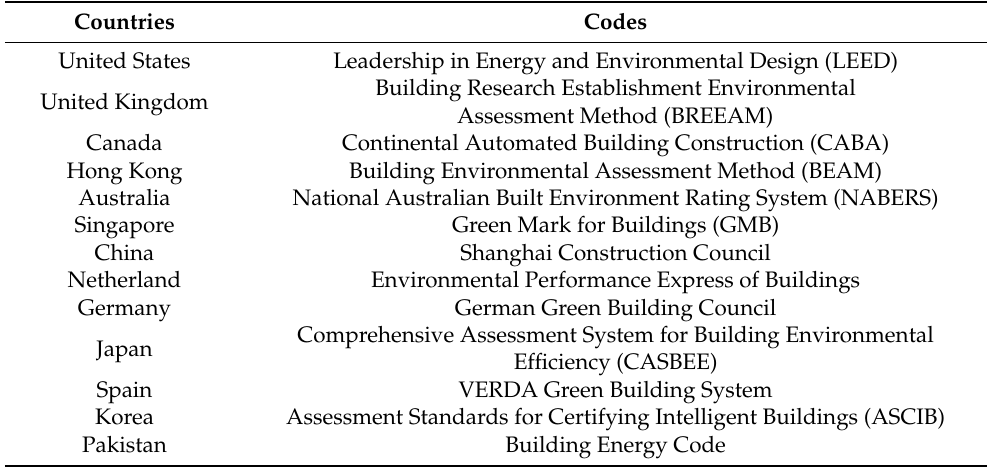
Table 1. Green building codes developed in different